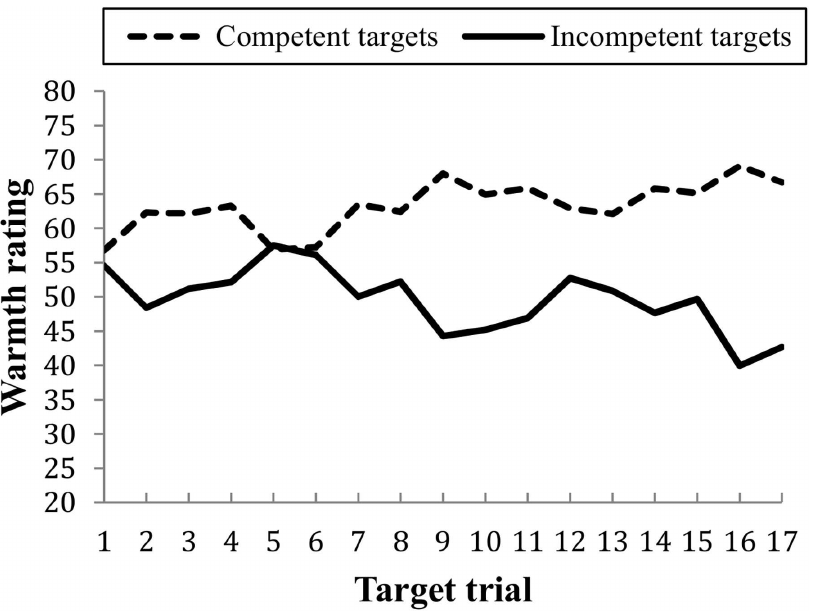
Fig 6. Competence ratings across the 17 trials for mainly competent and mainly incompetent targets. compared to the first trial; M = 11.83, SD = 12.67, t (71) = 7.92, p < .001 (Fig 6). The mean Diff difference between the first and the last ratings were not significant between competent and incompetent targets; t (71) = 1.04, p = .301.